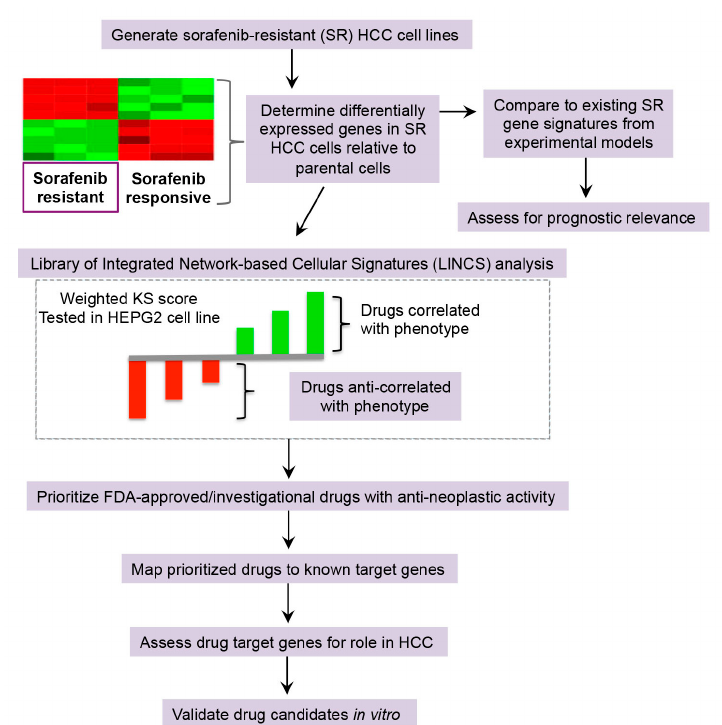
Figure 1. Overview of computational drug repurposing workflow and drug target network. Gene expression signatures of experimental models of hepatocellular carcinoma (HCC) sorafenib resistance were (i) assessed for prognostic significance, and (ii) queried against gene expression signatures characterizing drug perturbations in the HepG2 cell line contained in the Library of Integrated Network-based Cellular Signatures (LINCS) database. Connectivity scores were calculated by the rank-based, non-parametric weighted Kolgomorov-Smirnov (KS) statistic. Drugs with negative connectivity scores (i.e., anti-correlated) represent those that are hypothesized to reverse HCC sorafenib resistance gene signature. Drug candidates were further prioritized based on FDA approval/clinical investigation status, known anti-neoplastic activity and literature evidence for drug target genes associated with HCC. Two drugs were subsequently selected for in vitro validation.